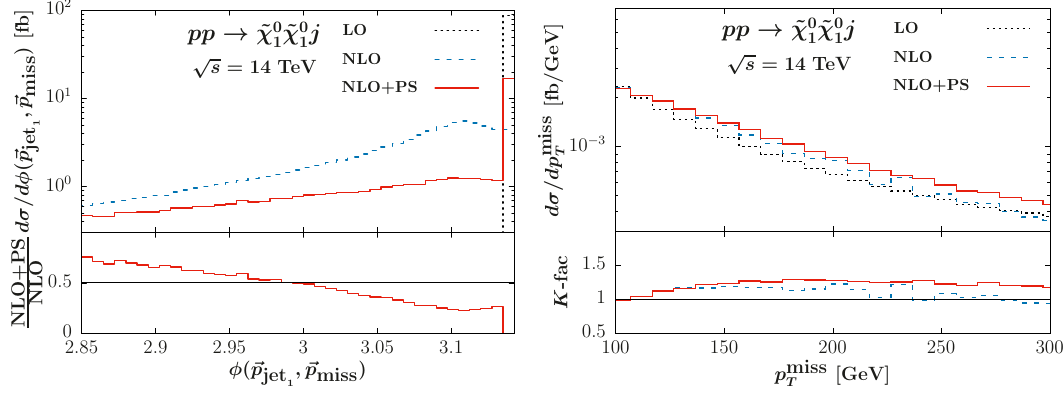
~ (cid:31) 0 ~ (cid:31) 0 j 1 1 !